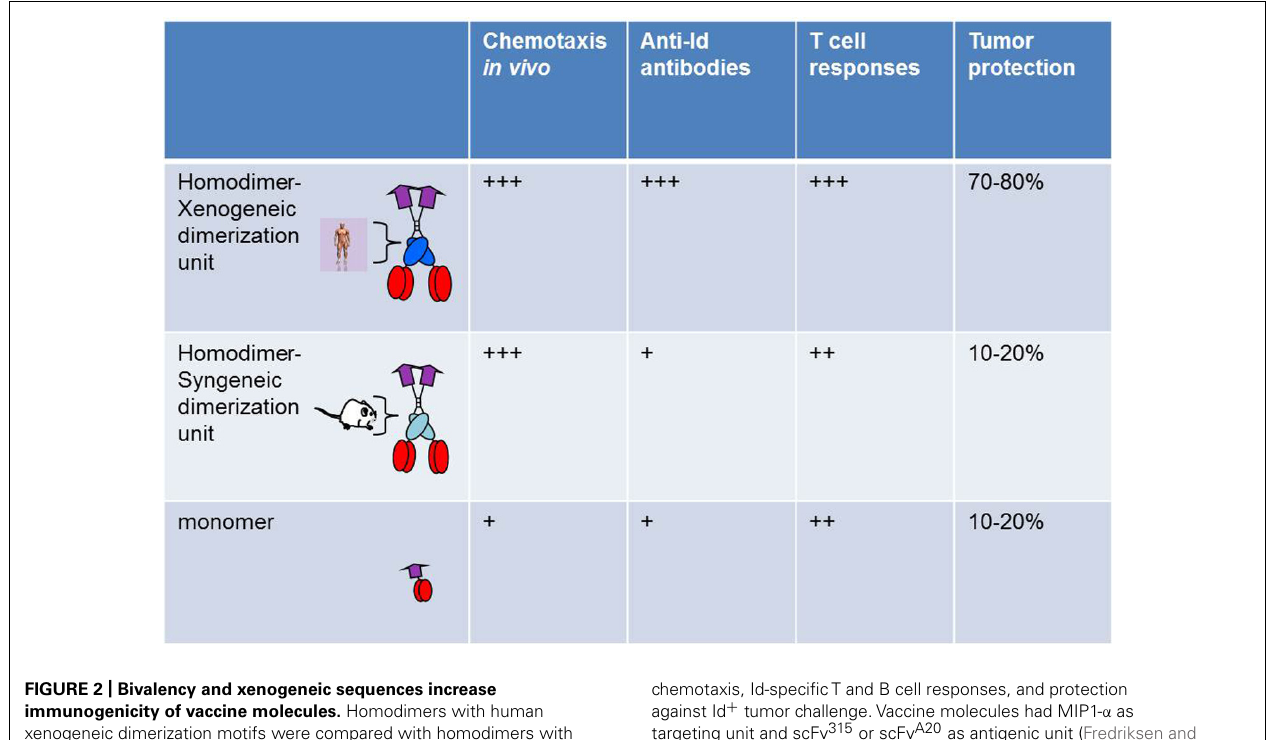
FIGURE 2 | Bivalency and xenogeneic sequences increase immunogenicity of vaccine molecules. Homodimers with human xenogeneic dimerization motifs were compared with homodimers with murine syngeneic dimerization motifs and monomers for induction of